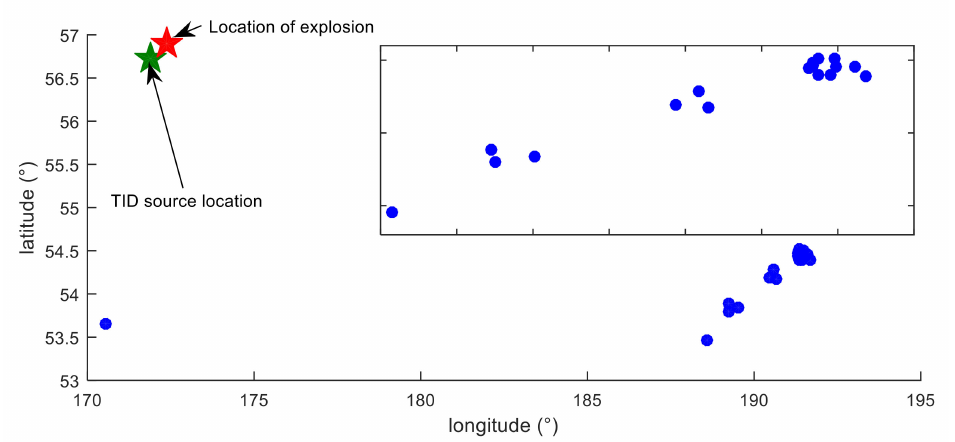
Figure 15. Estimation of TID source location. The red pentagram is the meteor explosion point, the green pentagram is the estimated TID source location, the blue dot is the position of the maximum amplitude of the TID, and the rectangular frame is an enlarged view of part of the